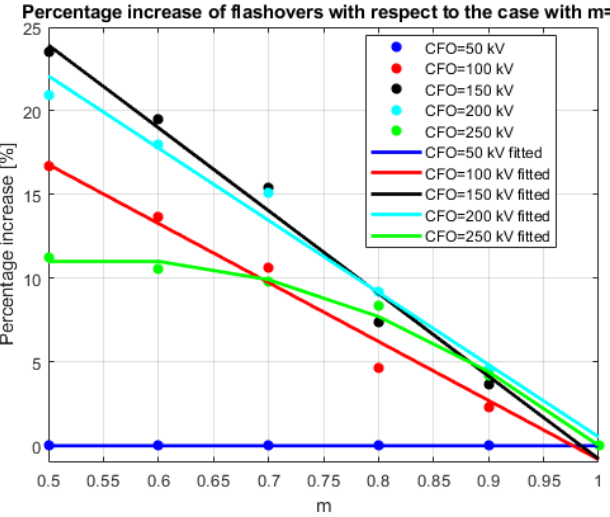
Figure 4. Percentage variation of the number of flashovers as a function of the surface state